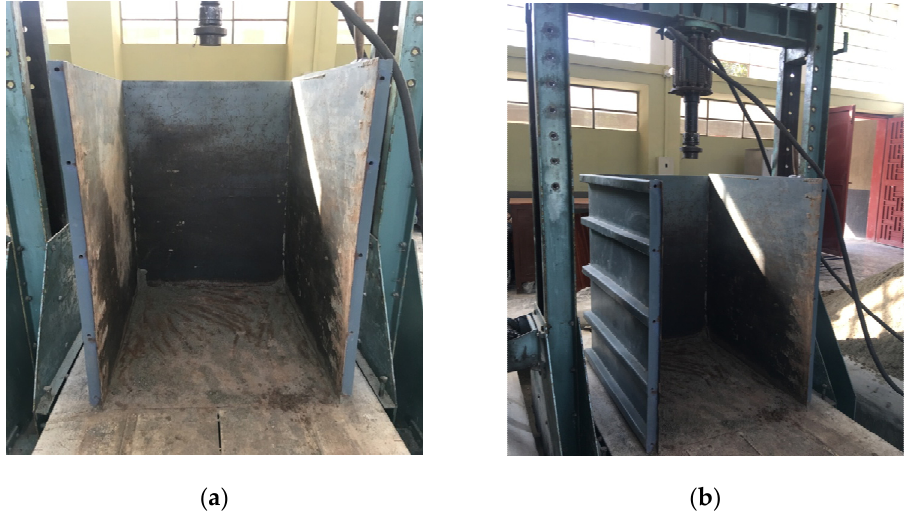
Figure 4. ( a ) The full scale model of MSE wall; ( b ) The MSE model with loading frame and hydraulic jack.